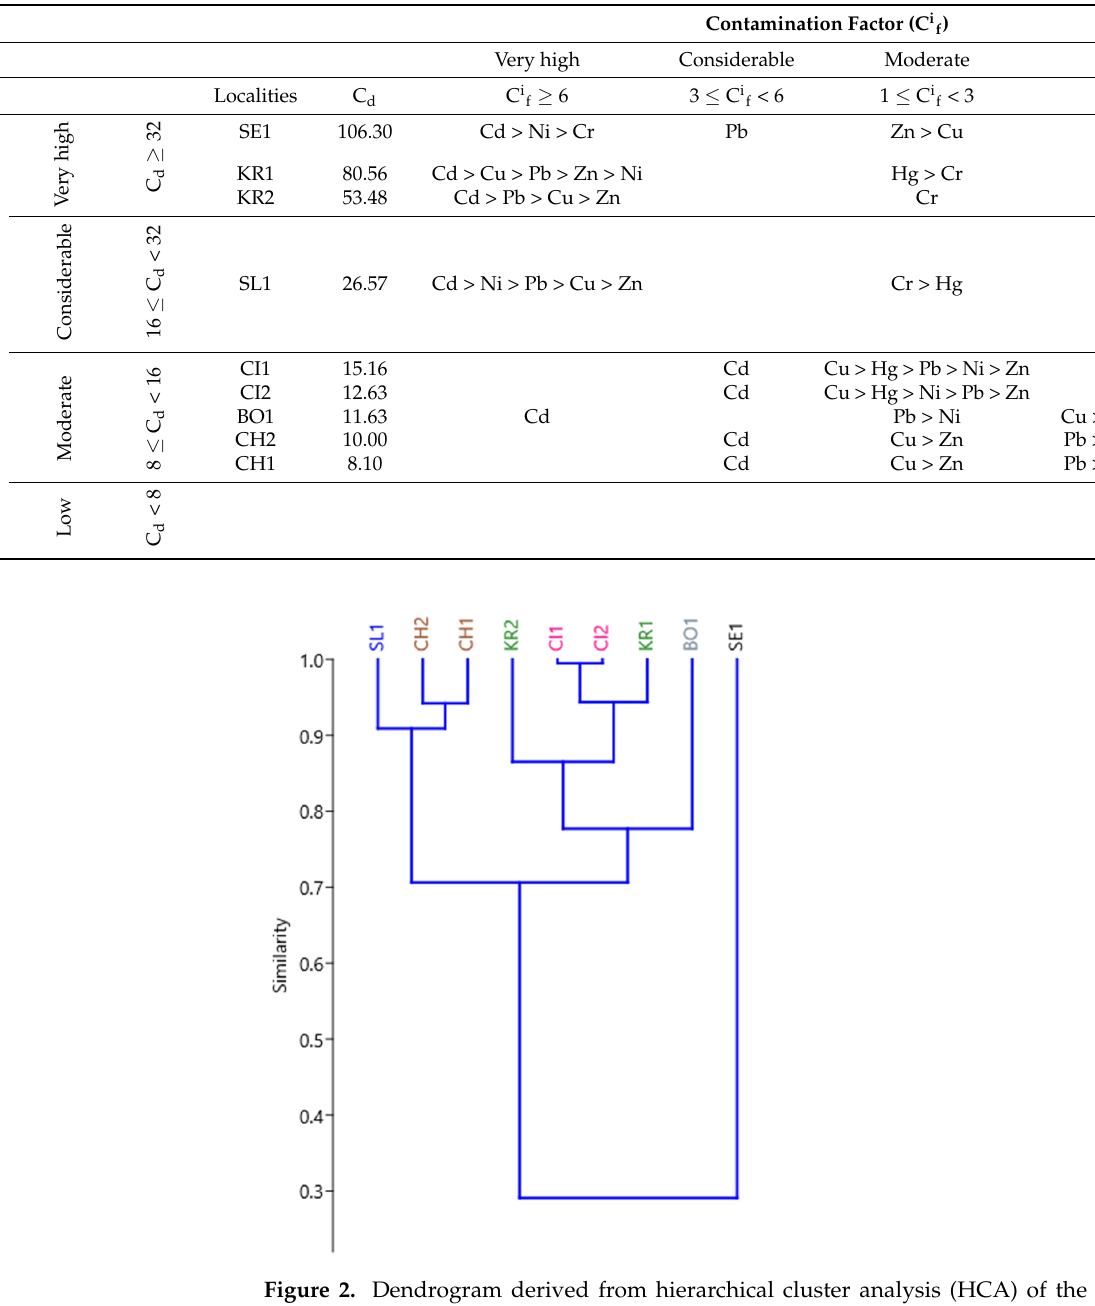
Table 4. Ranking order of soil contamination of the investigated localities according to C d –value and sequence of the contamination factors (C i f ).